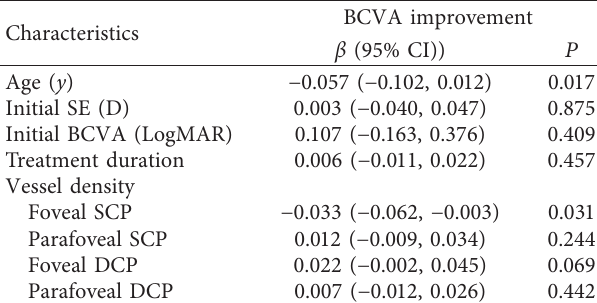
Table 4: Multiple linear regression analysis for associations of the BCVA improvement with age, refraction, BCVA at initial visit, duration of treatment, and macular vessel